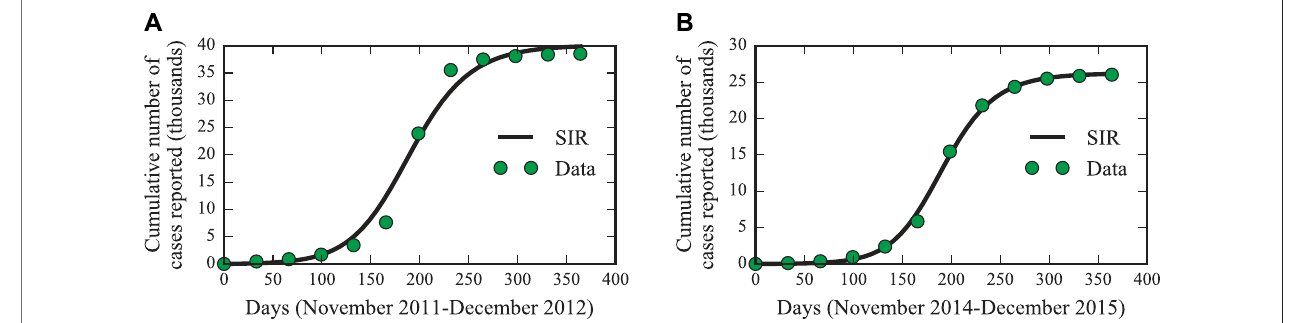
FIGURE 7| SIR model fi tfor the epidemic years 2012 and 2015. The maximum likelihood fi ts of the SIR model (black solid lines) asde fi ned by Eqs. 5 – 7 , 10 for the epidemic years 2012 (A) and 2015 (B) . The cumulative number of reported dengue cases according to our data set is indicated by green dots.